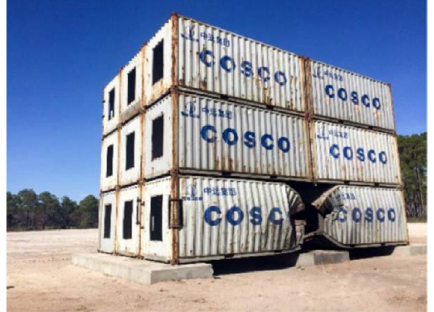
Figure 3. Field test on CONEX for progressive collapse [93].